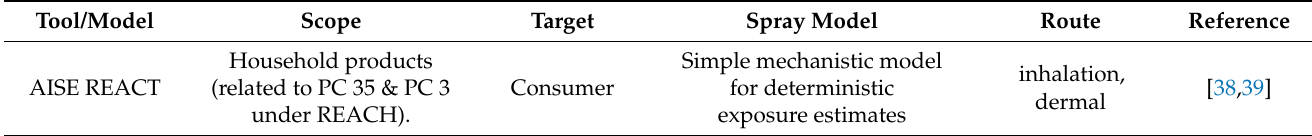
Table 1. Tools generally suited to estimate human exposure to spray mist; a short description of the underlying model structure of each of these and few other tools as well as the input parameters and the output data are given in Supplementary Materials (Table S1). REACH stands for Registration, Evaluation, Authorisation and Restriction of